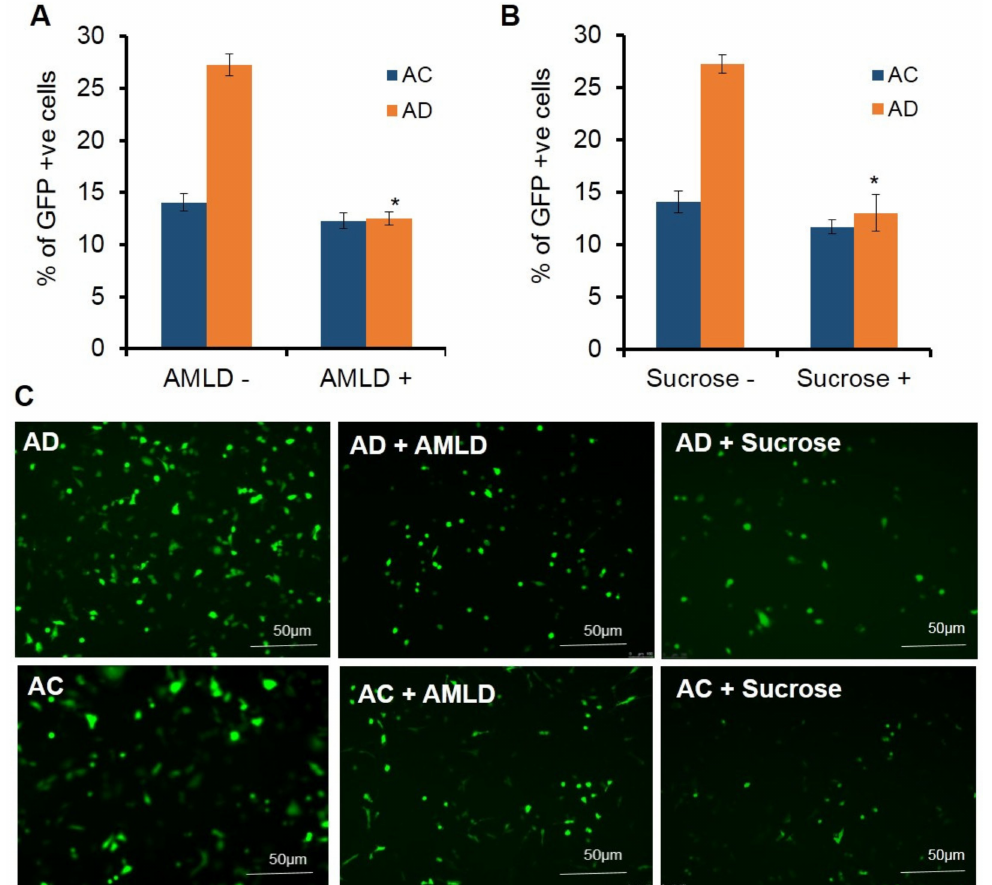
Figure 4. Effect of macropinocytosis inhibitors/blockers on transfection activity. % of GFP-positive cells assessed by Flow cytometric analysis in amiloride (AMLD) pretreated SK-Hep1 cells ( A ). % of GFP-positive cells assessed by Flow cytometric analysis in sucrose pretreated SK-Hep1 cells ( B ). Representative fluorescence micrographic images for cells transfected using AD with and without inhibitors ( C upper panel). AC with and without inhibitors ( C lower panel). * p <